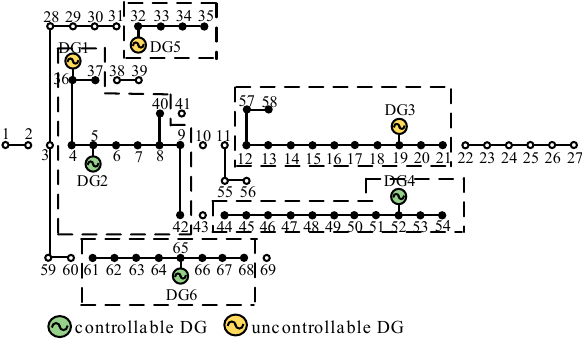
Figure 7. Island partition formed by the method in [8].